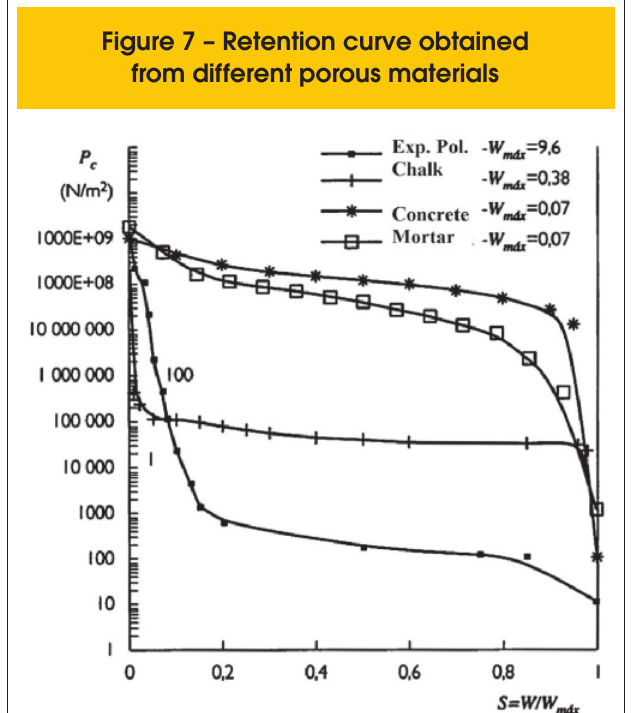
Source: Freitas, Torres and Guimarães